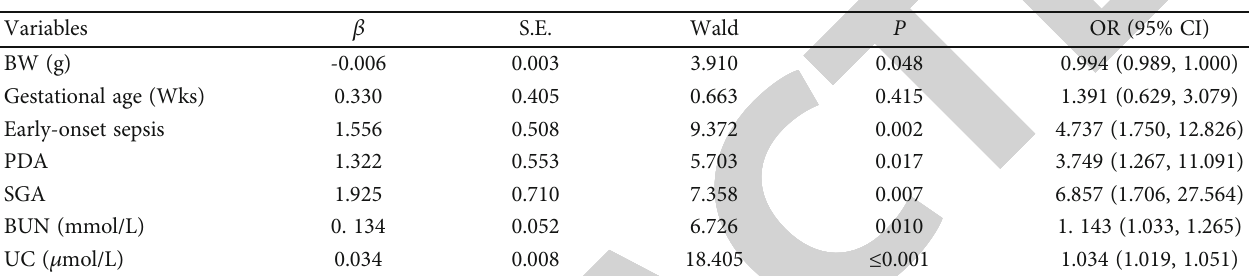
Table 3: Multivariate logistic regression on factors independently predicting the BPD-PAH risk.